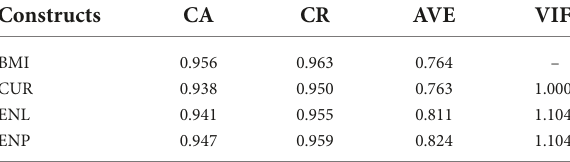
TABLE 3 Construct reliability and validity.